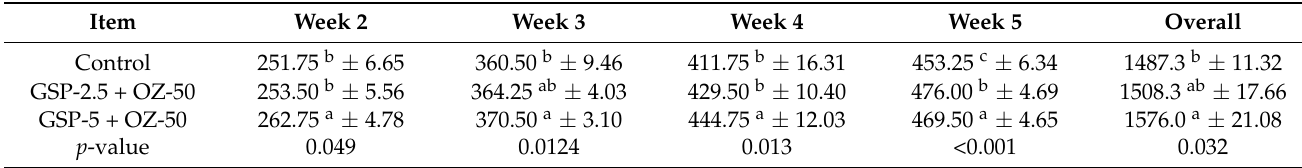
Table 4. Body weight gain (g/bird) (g ± SE) in broiler chicks fed different levels of zinc–glycine chelate and grape seed powder under summer stress conditions.